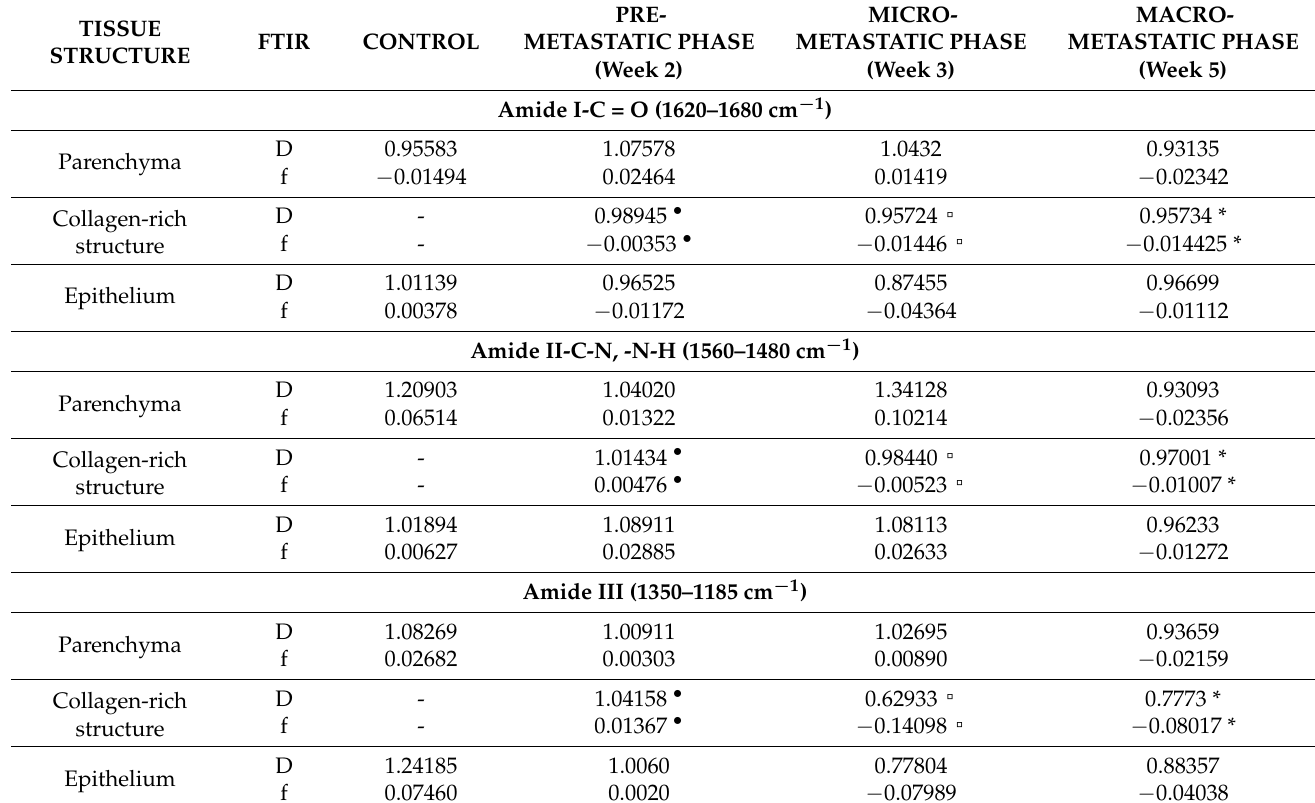
• fibrotic tissue;